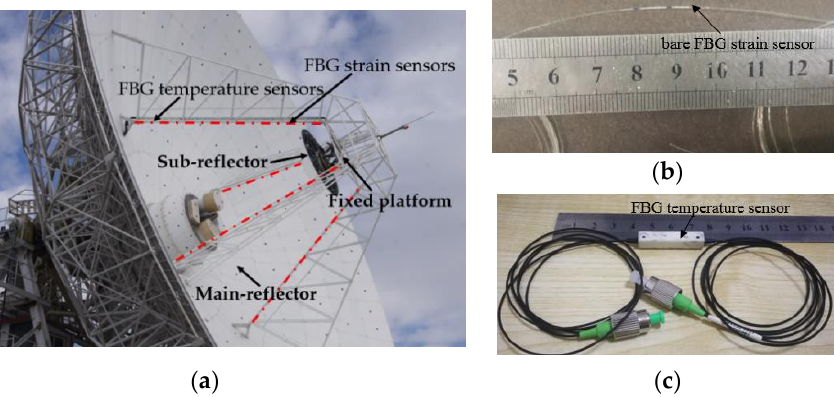
Figure 1. ( a ) Radio telescope and sensor placement, ( b ) bare fiber Bragg grating (FBG) strain sensor, Figure 1. (a) Radio telescope and sensor placement, (b) bare fiber Bragg grating (FBG) strain sensor, and ( c ) FBG temperature and (c) FBG temperature sensor.